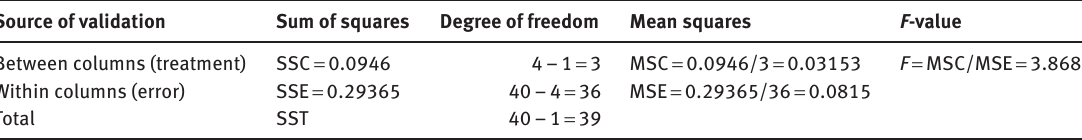
Table 7: ANOVA Calculation for the Error % Using Three Segmentation Methods and the Proposed Method. Source of validation Sum of squares Degree of freedom Mean squares F -value Between columns (treatment) SSC = 0.0946 4 − 1 = 3 MSC = 0.0946/3 = 0.03153 Within columns (error) SSE =